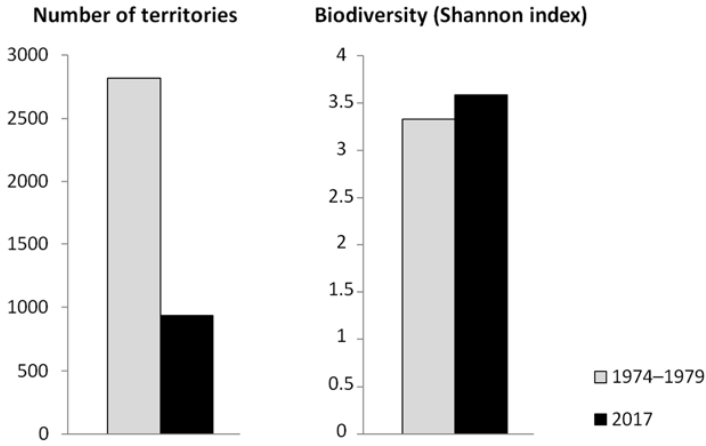
Figure 4. Number of territories across species at “Lampertheimer Altrhein” and Shannon index between 1974 and 1979 (average values) and in 2017. The number of territories for 2017 was extrapolated to the size of the study area in 1974–1979.